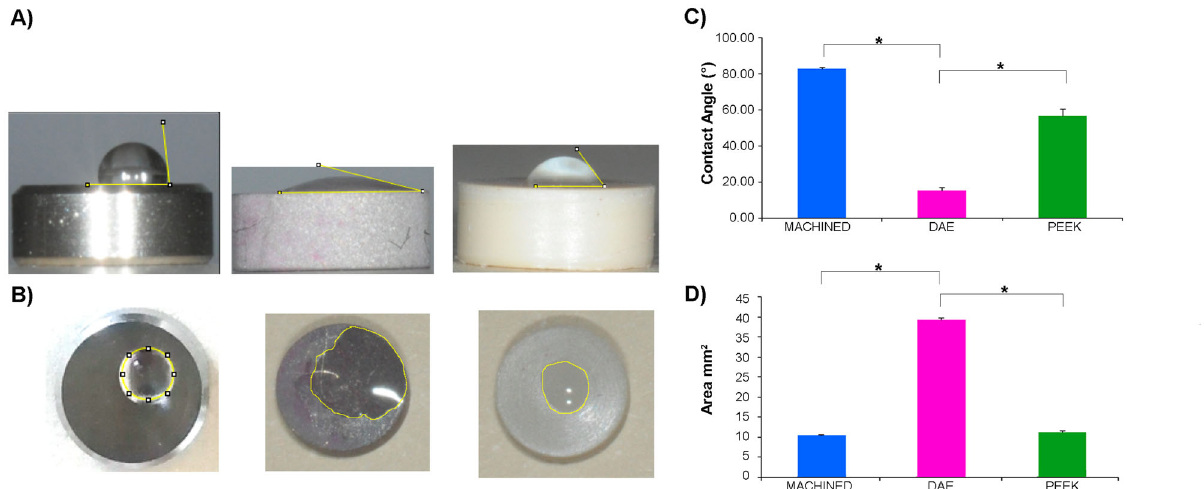
Fig. 4 a Static contact angles with the sessile drop method of machined, DAE and PEEK. c Average water contact angle (* p -value < 0.05). b The wetted area of machined, DAE, PEEK. d Average wetted area of the samples (* p -value < 0.05)